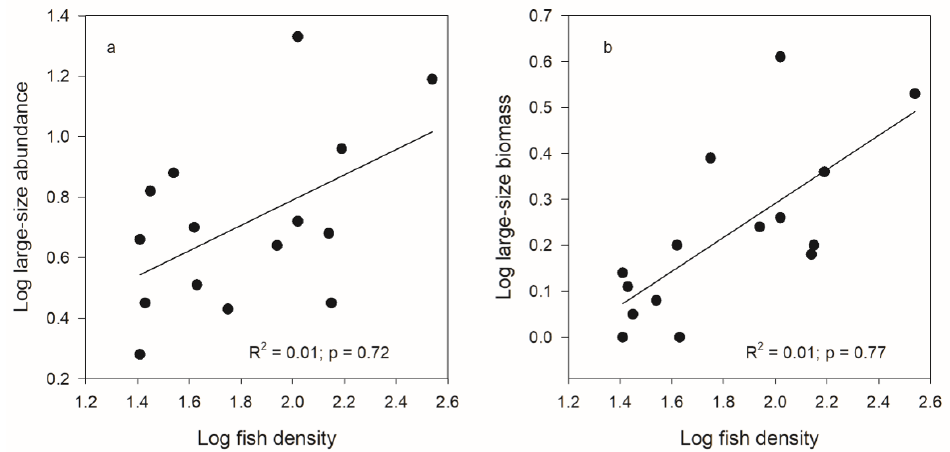
Figure 8. Association of ( a ) abundance and ( b ) biomass of large-sized zooplankton with fish density. All data were log (x + 1) transformed prior to